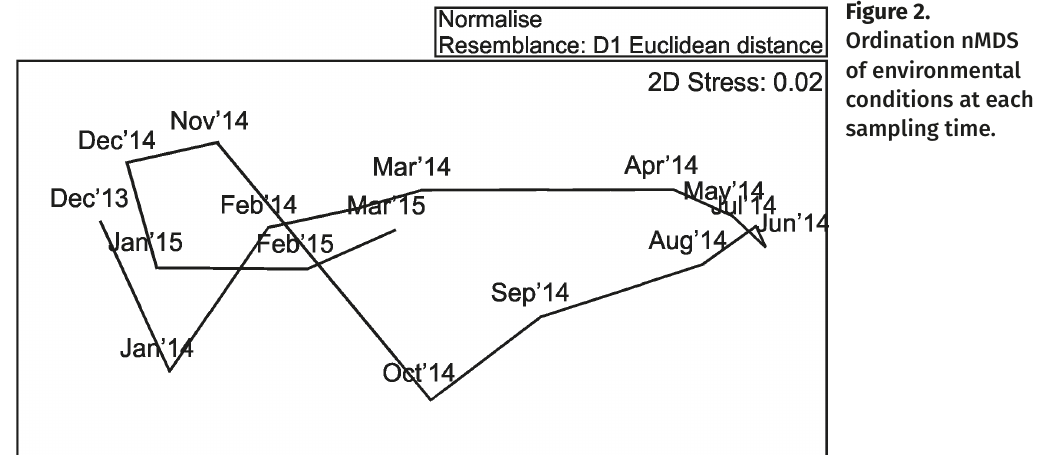
Figure 2. Ordination nMDS of environmental conditions at each sampling